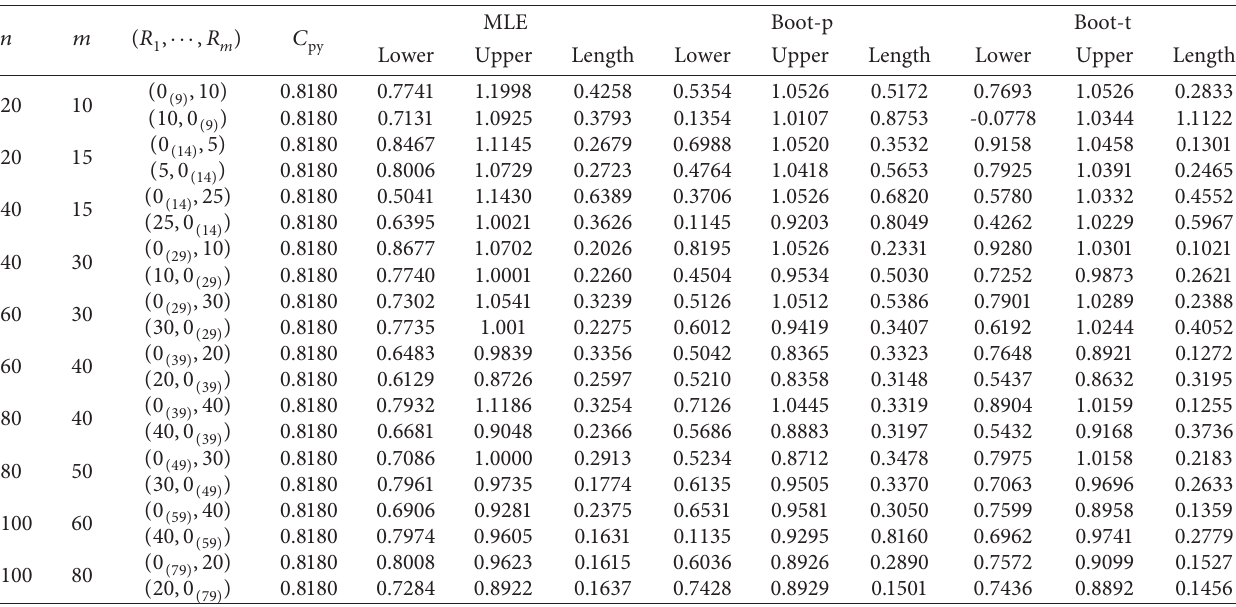
Table 8: True value of C and 95% CIs of MLE, Boot-p and Boot-t when α � 4 . 40 , θ � 5 . 79 , and c � 0 . 77. py